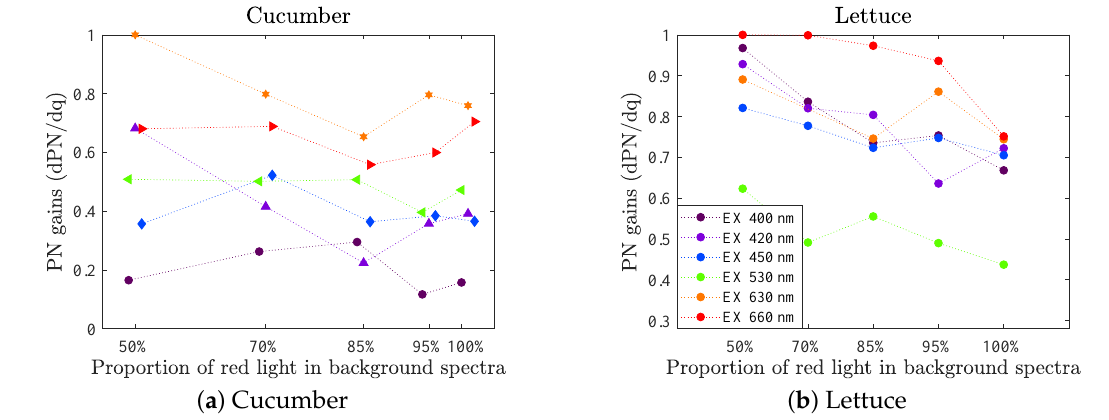
Figure 9. Photosynthetic rate gains for each of the six LED colours when the background light quality varies from 50–100% red light, for ( a ) cucumber and ( b ) lettuce, normalized to the highest gain. Background intensity level was 160µmolm − 2 s − 1 (set A). The plot shows the mean value of measurements on 4 different